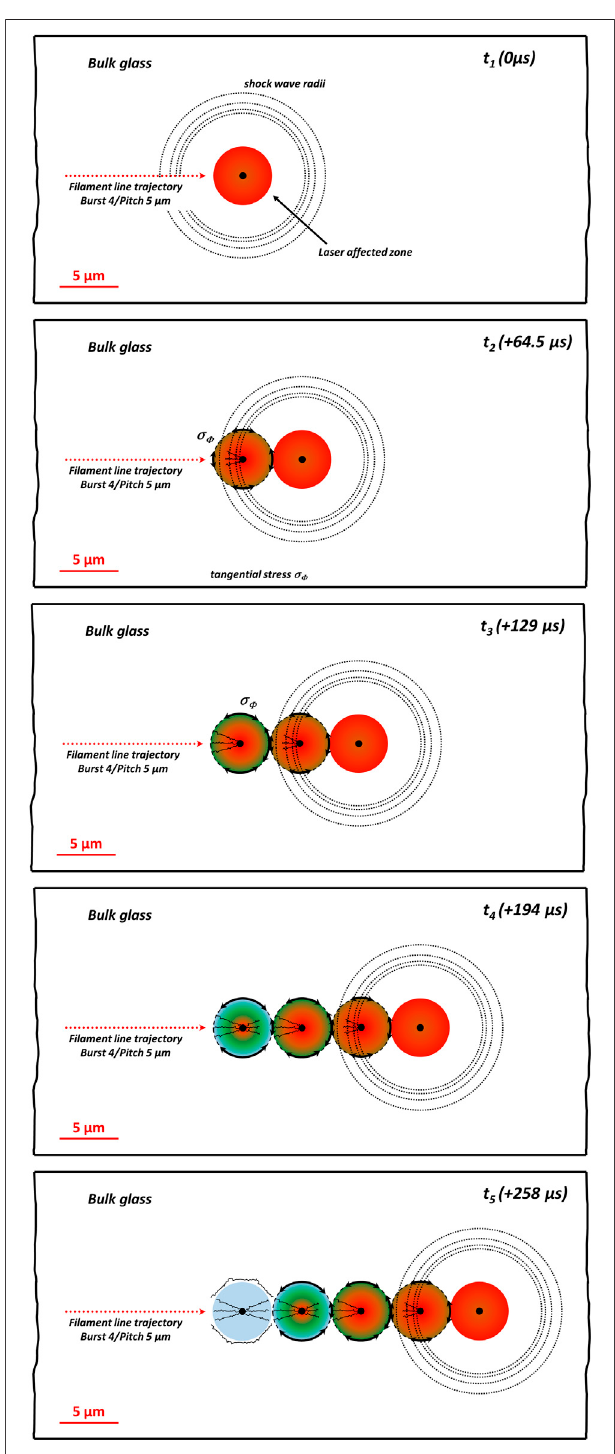
FIGURE 13 | Schematic model of fi lament and micro crack formation with accompanied thermal effects and shock wave emission. Sketches were done in increments of 64.5 µs as it was the time for the stage to travel to the next dedicated fi lament position (noted in the top right corner). Parameters were chosen to be Burst 4/Pitch 5 and the diameter of the laser- affected zone was set to be 5 µm. Colors indicate the current temperature